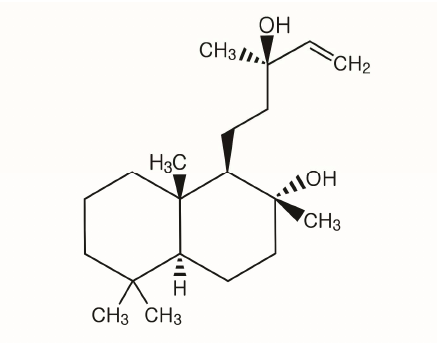
Figure 1. Chemical structure of sclareol.